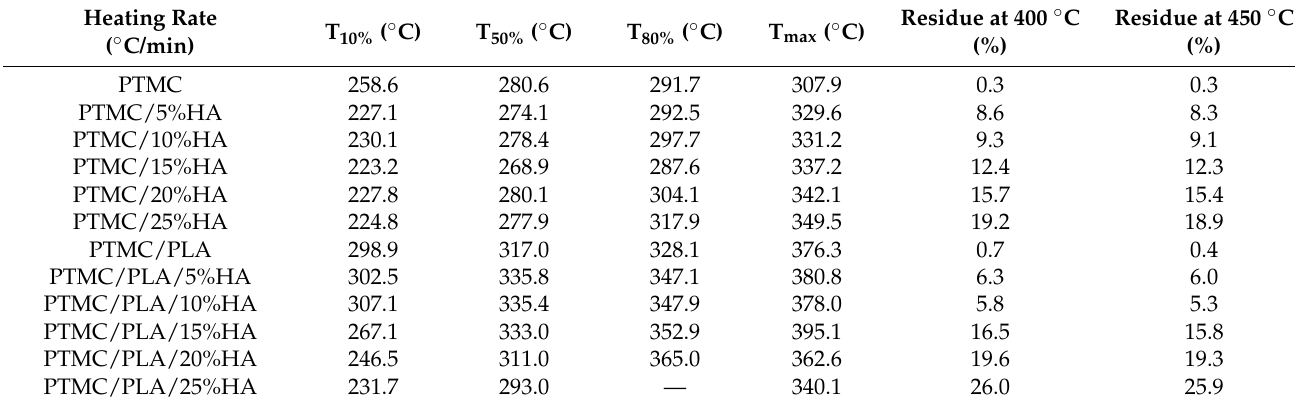
Table 2. Thermal properties of PTMC/HA and PTMC/PLA/HA